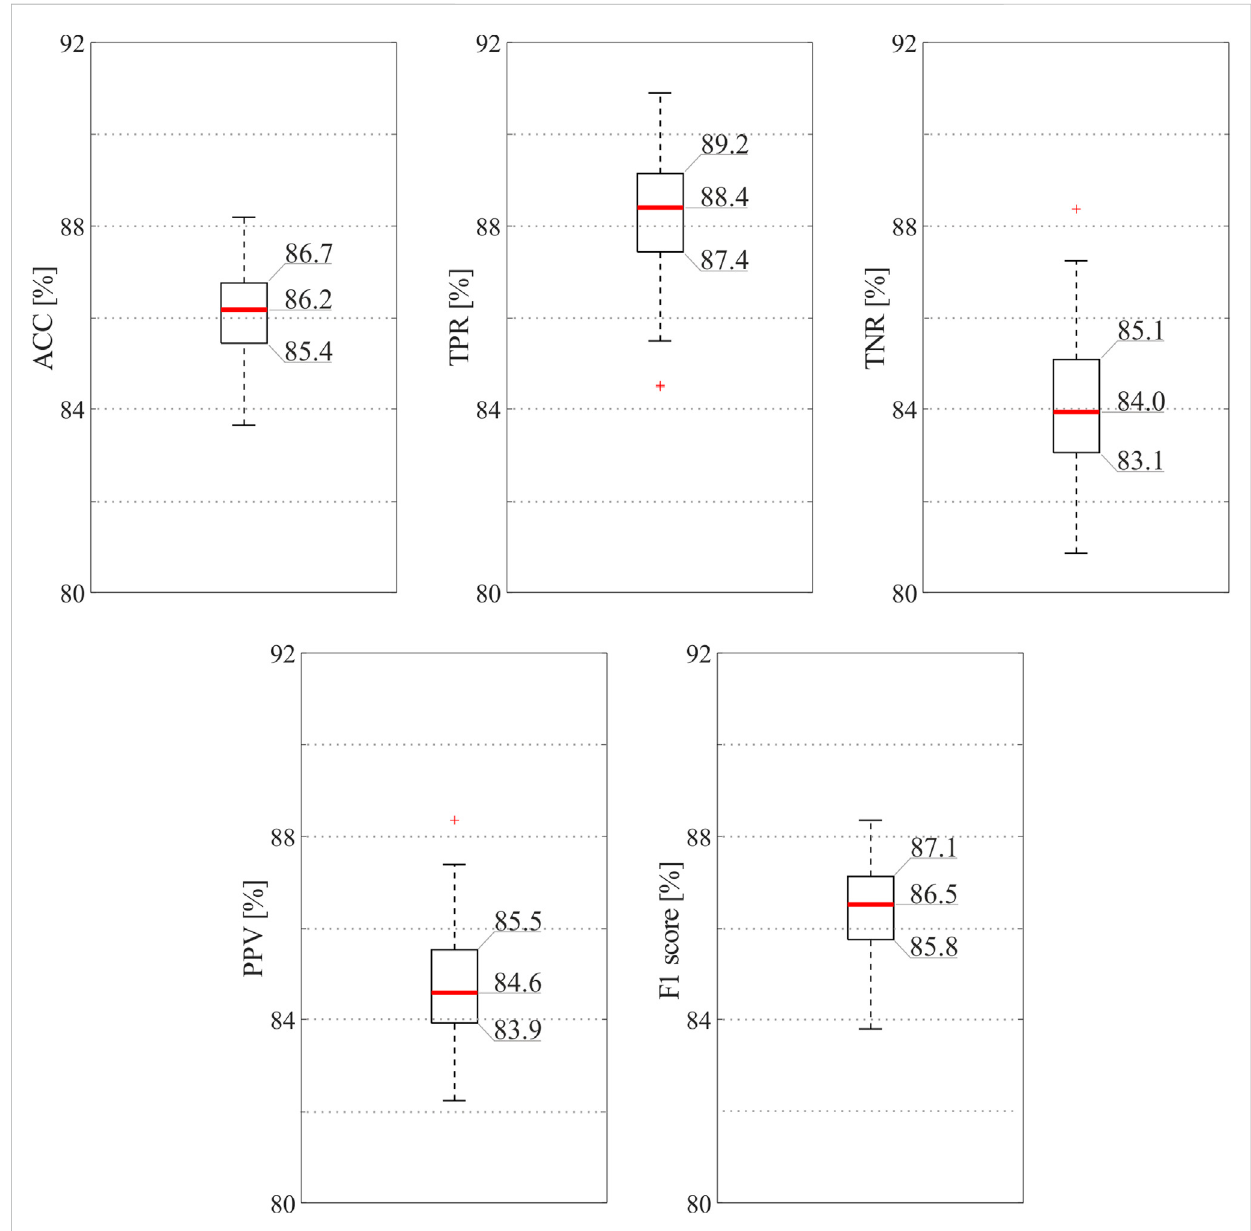
FIGURE 3 SQI-basedclassi fi cationresultsobtainedbytheensembletreeexploitingallavailablefeatures.Inordertoprovidethereaderwithanaccuratedisplay of the results, exact values are reported for the 25th and 75th percentiles and for the